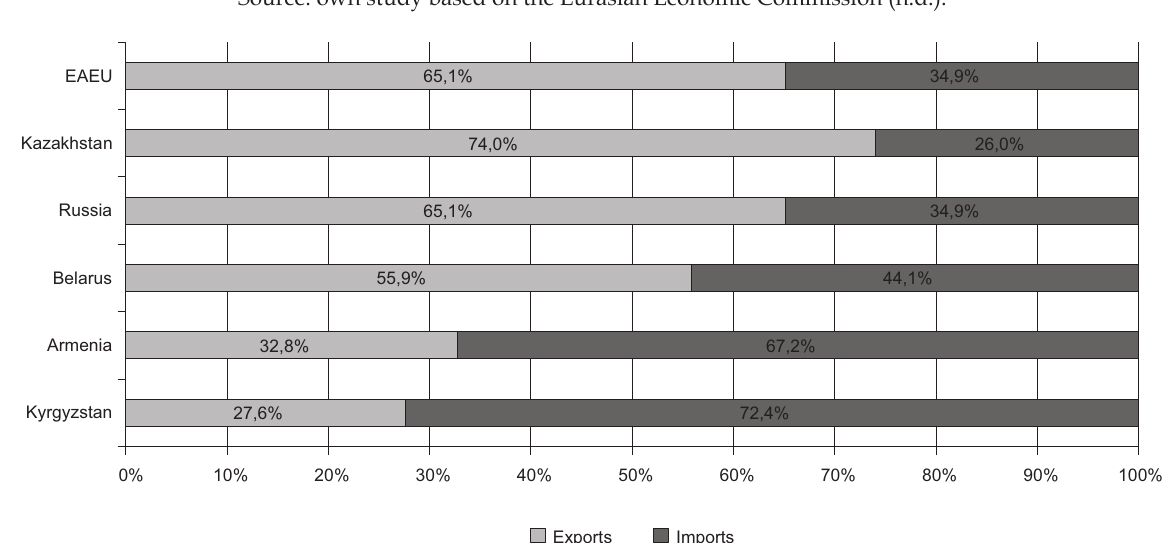
Fig. 5. Structure of foreign merchandise trade by the EAEU member states in 2018. Source: own study based on the Eurasian Economic commission